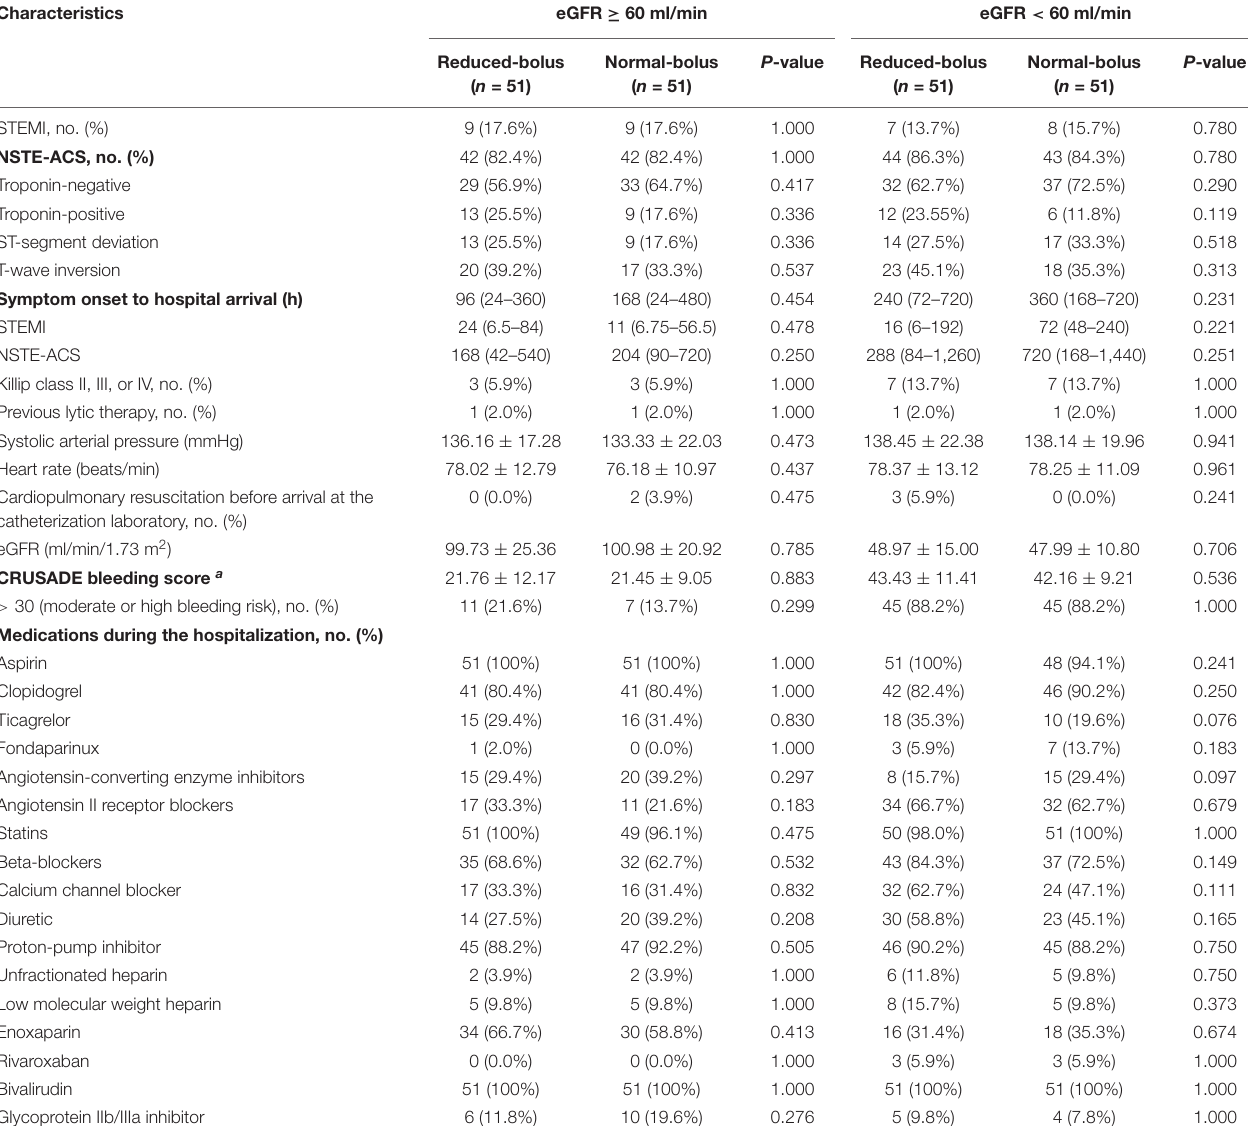
TABLE 2 | Clinical presentation and medications at